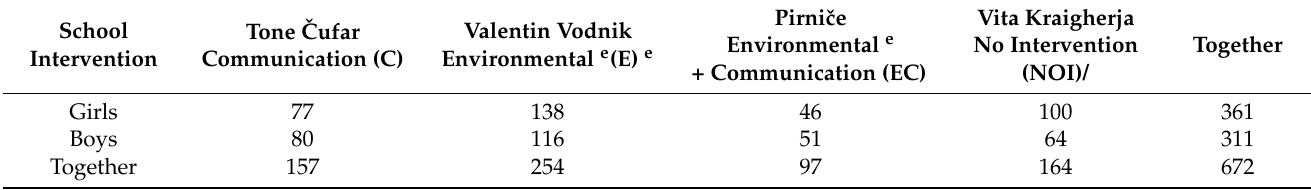
Table 2. Study sample.